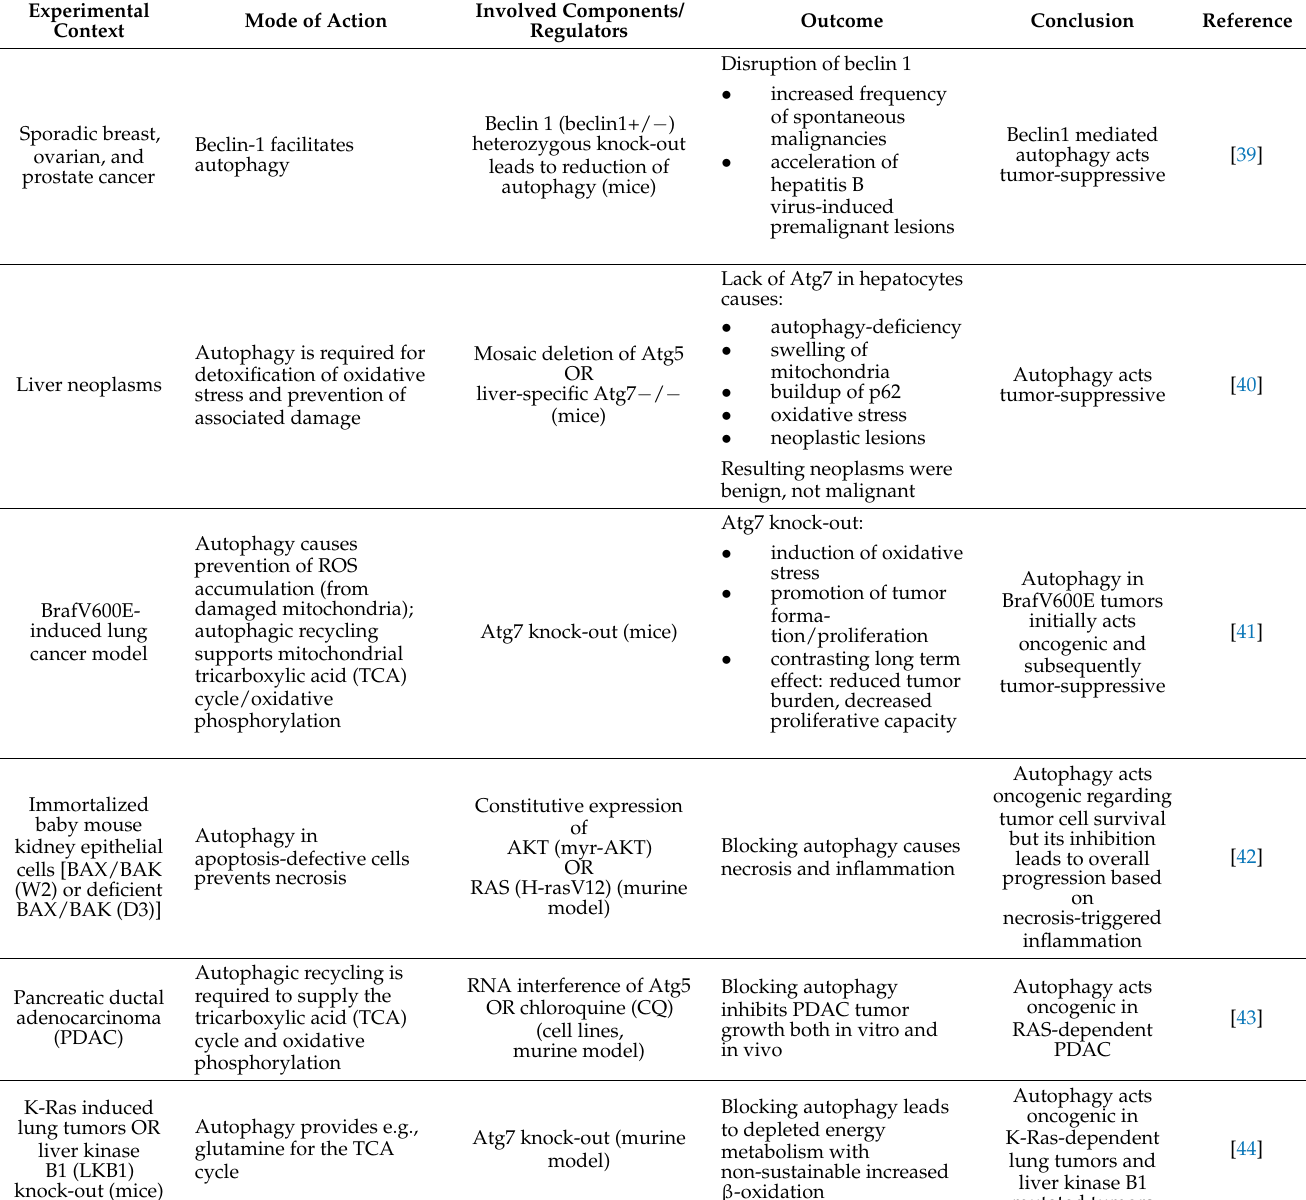
Table 1. Selected tumor-suppressive and oncogenic functions of autophagy in cancer and the corresponding regulators. Experimental